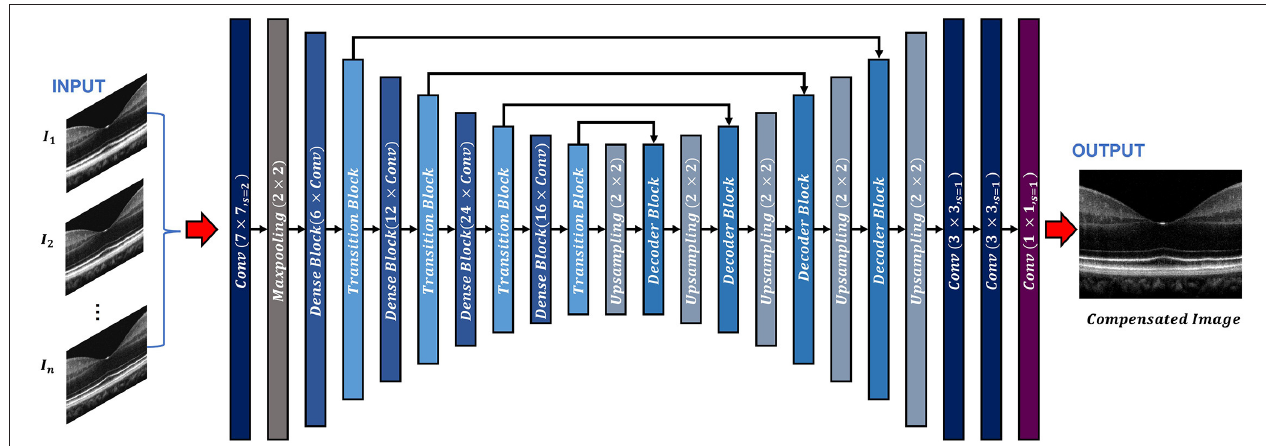
FIGURE 1 | Overview of the ADC-Net architecture. Conv stands for convolution operation. The input section is comprised of OCT B-scans compensated by different second order coefficients ( n = 3, 5, 7, and 9 for three, five, seven, and nine input channel models. A single image is used as input for the single input channel model). The output image is a corresponding fully compensated OCT